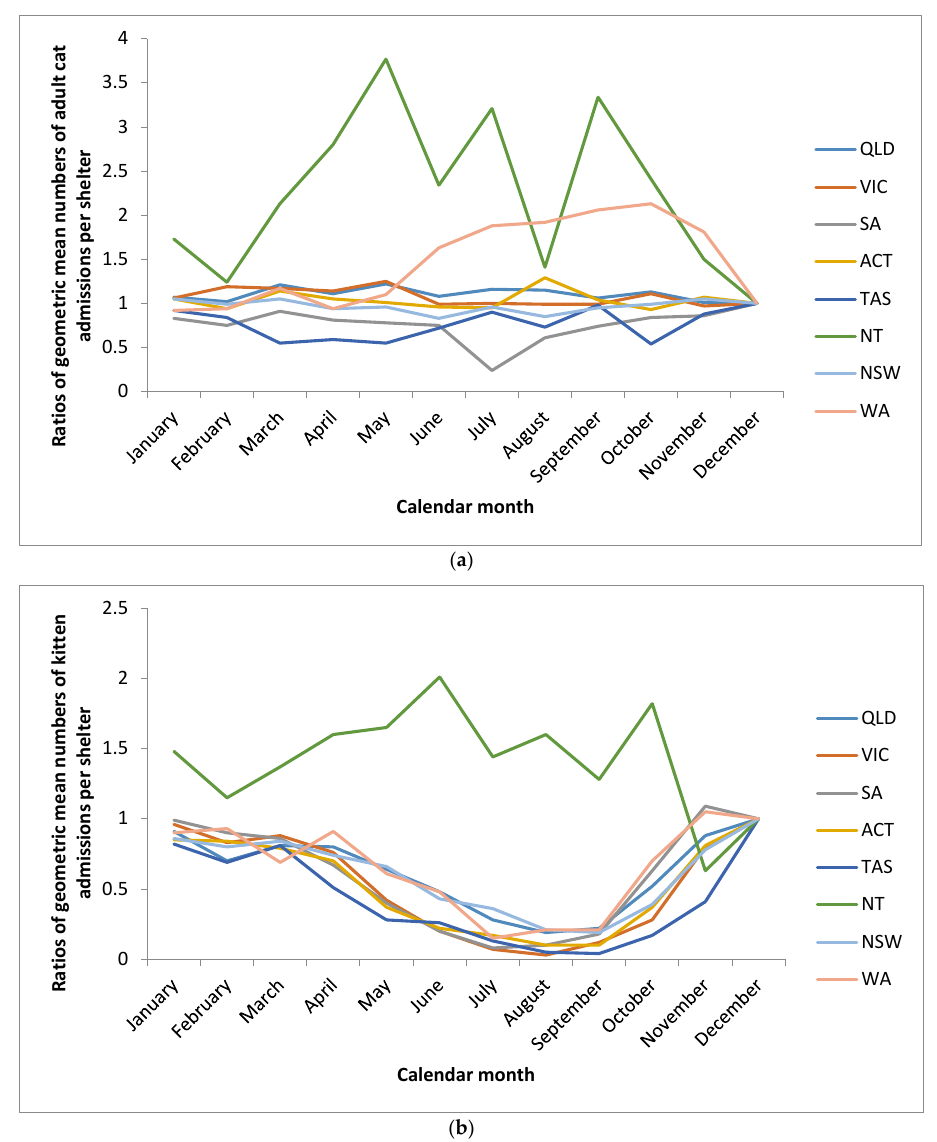
Figure 2. Ratios of geometric mean numbers of cat admissions per RSPCA shelter per month for January to November relative to December by state/territory. ( a ) Ratios of geometric mean numbers of Adult Cat admissions per RSPCA shelter per month for January to November relative to December by state/territory; ( b ) Ratios of geometric mean numbers of Kitten admissions per RSPCA shelter per month for January to November relative to December by state/territory. (Queensland (QLD), Victoria (VIC), South Australia (SA), Australian Capital Territory (ACT), Tasmania (TAS), Northern Territory (NT), New South Wales (NSW), and Western Australia (WA)). * For example, in Northern Territory (NT), the geometric mean number of adult cat admissions per shelter in January was 1.7 times higher than that in December.